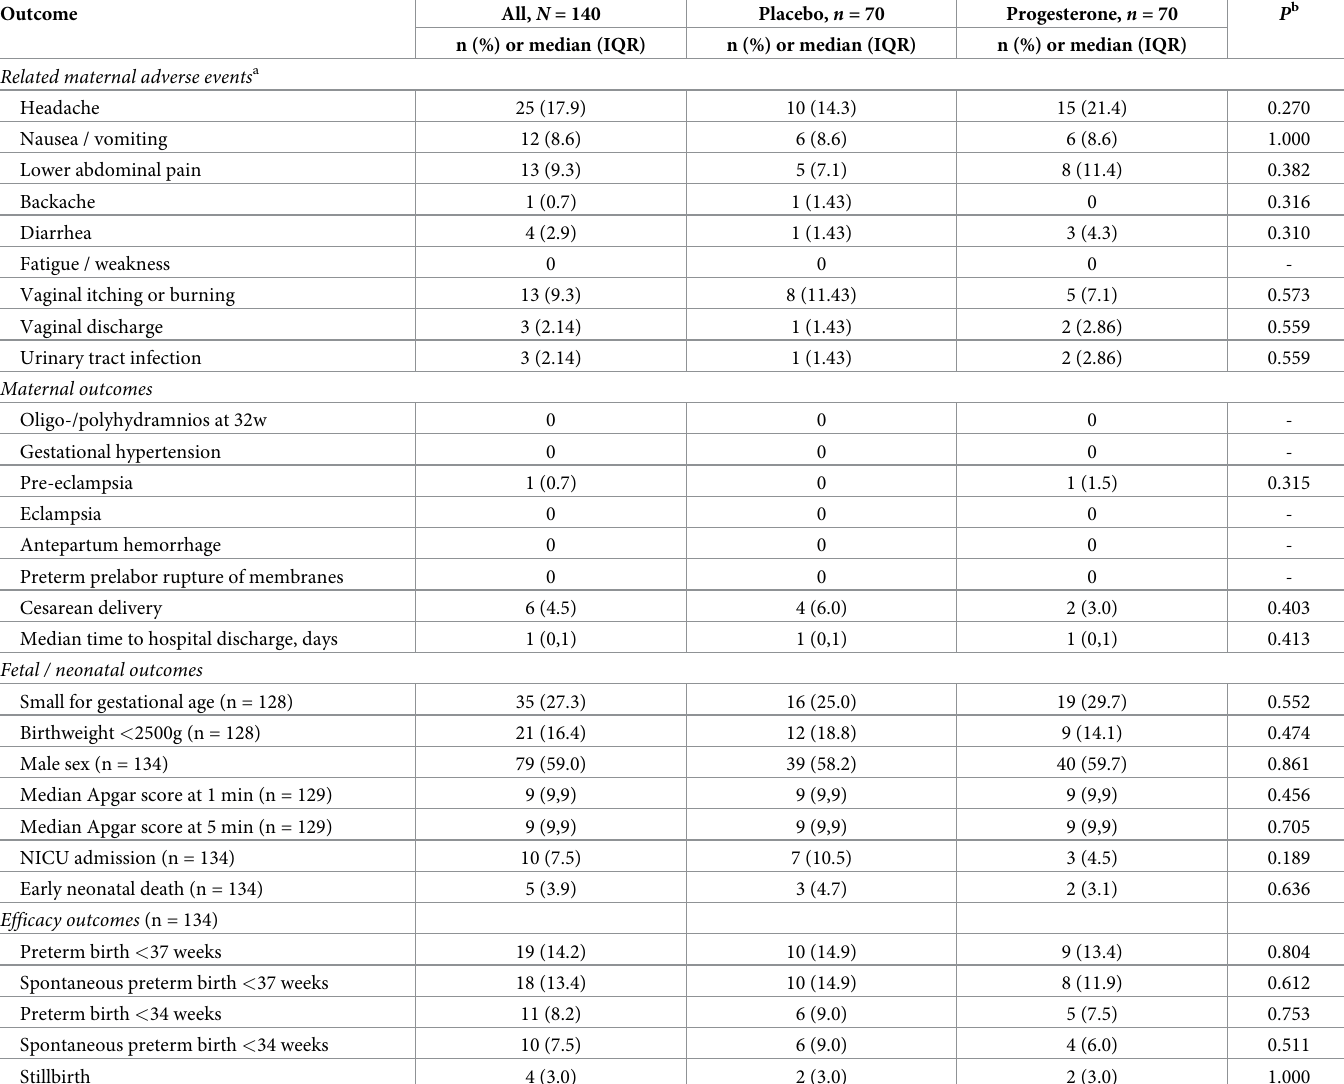
Table 6. Frequency of safety and efficacy outcomes by study